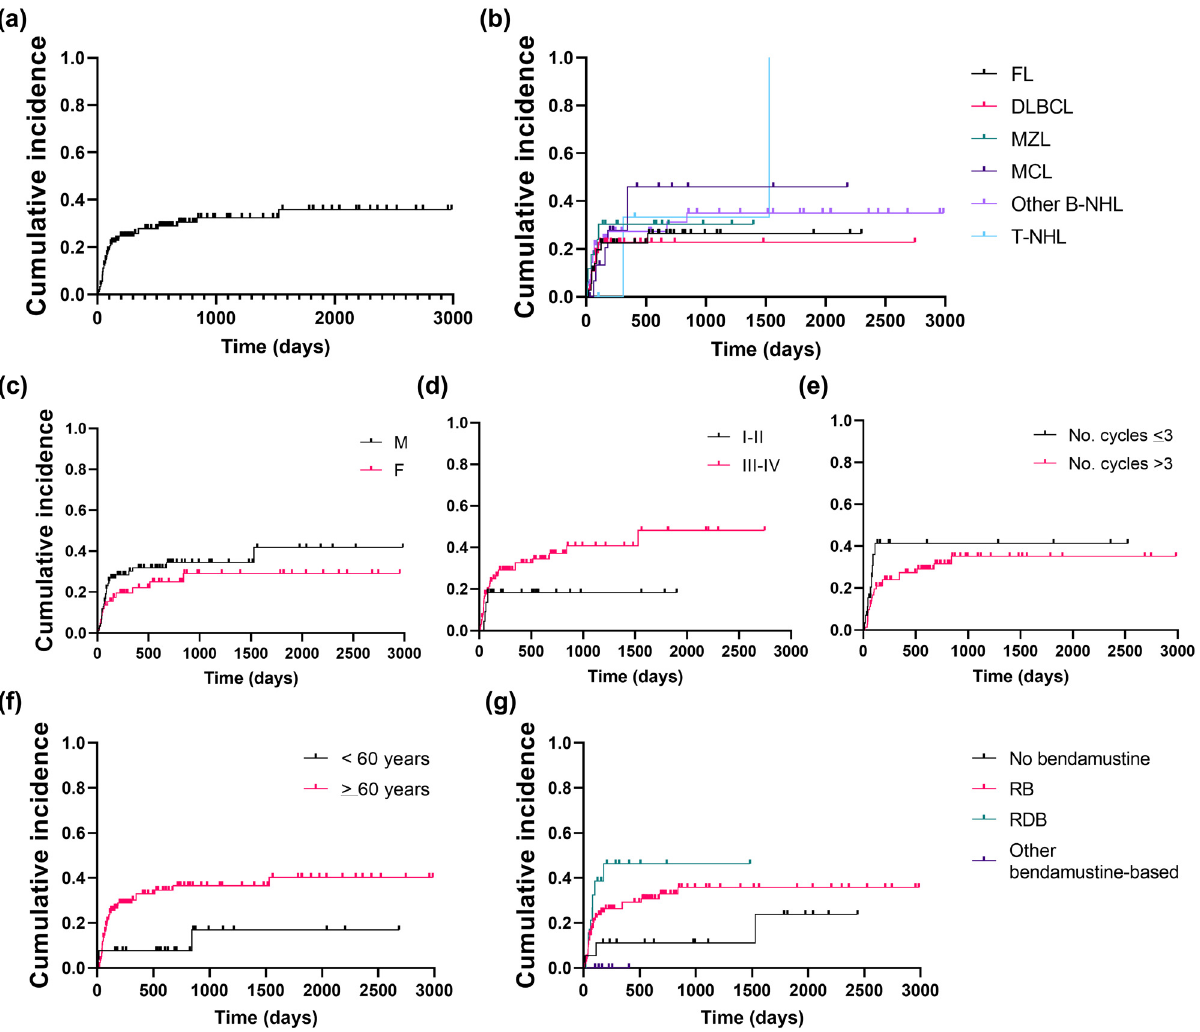
Figure 3: Cumulative incidence of CMV reactivation in NHL patients treated with bendamustine. ( a ) Cumulative incidence of CMV reactivation was fi rst assessed on the entire cohort of patients diagnosed with NHL receiving bendamustine - containing regimens as fi rst or above line of treatment. Then, in fl uence of various clinical categories on the incidence of CMV reactivation was assessed by dividing patients based on: ( b ) type of lymphoma ( FL, follicular lymphoma; DLBCL, di ff use large B cell lymphoma; MZL, marginal zone lymphoma; MCL, mantle cell lymphoma; other B - NHL, other B - cell non - Hodgkin lymphomas; T - NHL, T - cell non - Hodgkin lymphomas ) ; ( c ) sex ( M, male; F, female ) ; ( d ) disease stage ( stage I – II, and stage III – IV ) ; ( e ) number ( No. ) of bendamustine cycles ( ≤ 3 or > 3 ) ; ( f ) age (< 60 years old [ yo ] or ≥ 60 years old ) ; and ( g ) therapeutic regimens administered as fi rst - line therapy ( not - containing bendamustine; RB, rituximab plus